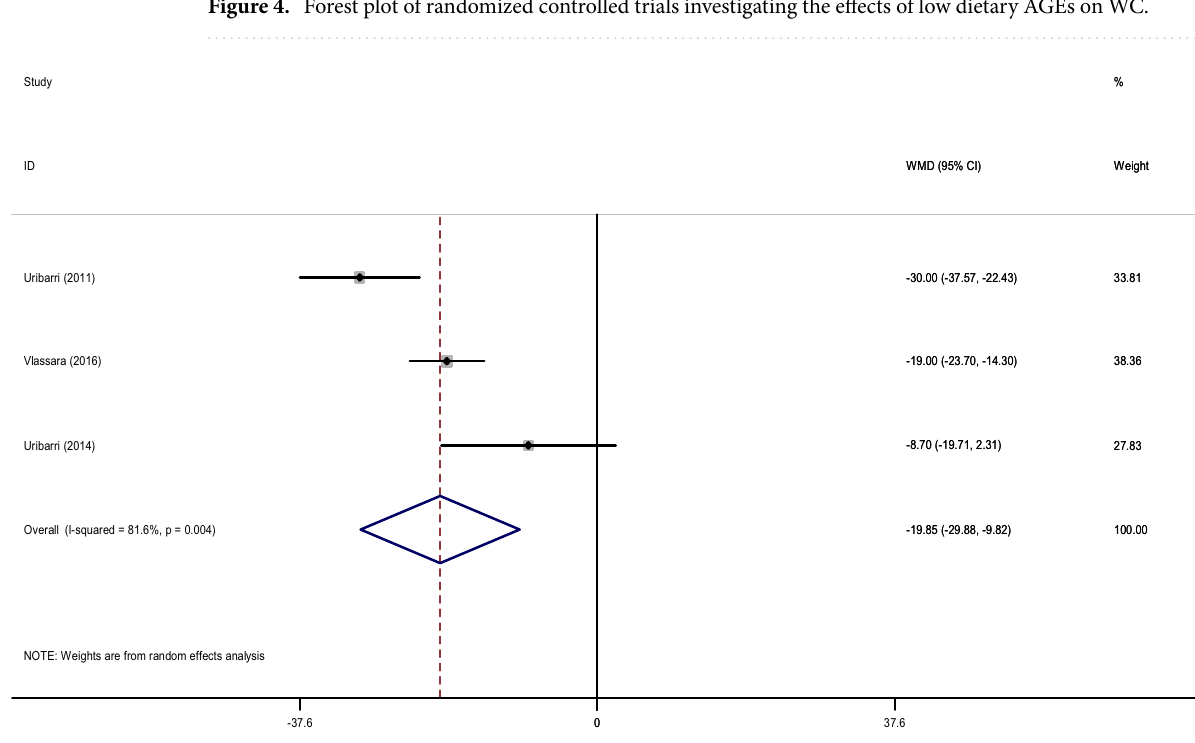
Figure 5. Forest plot of randomized controlled trials investigating the effects of low dietary AGEs on leptin